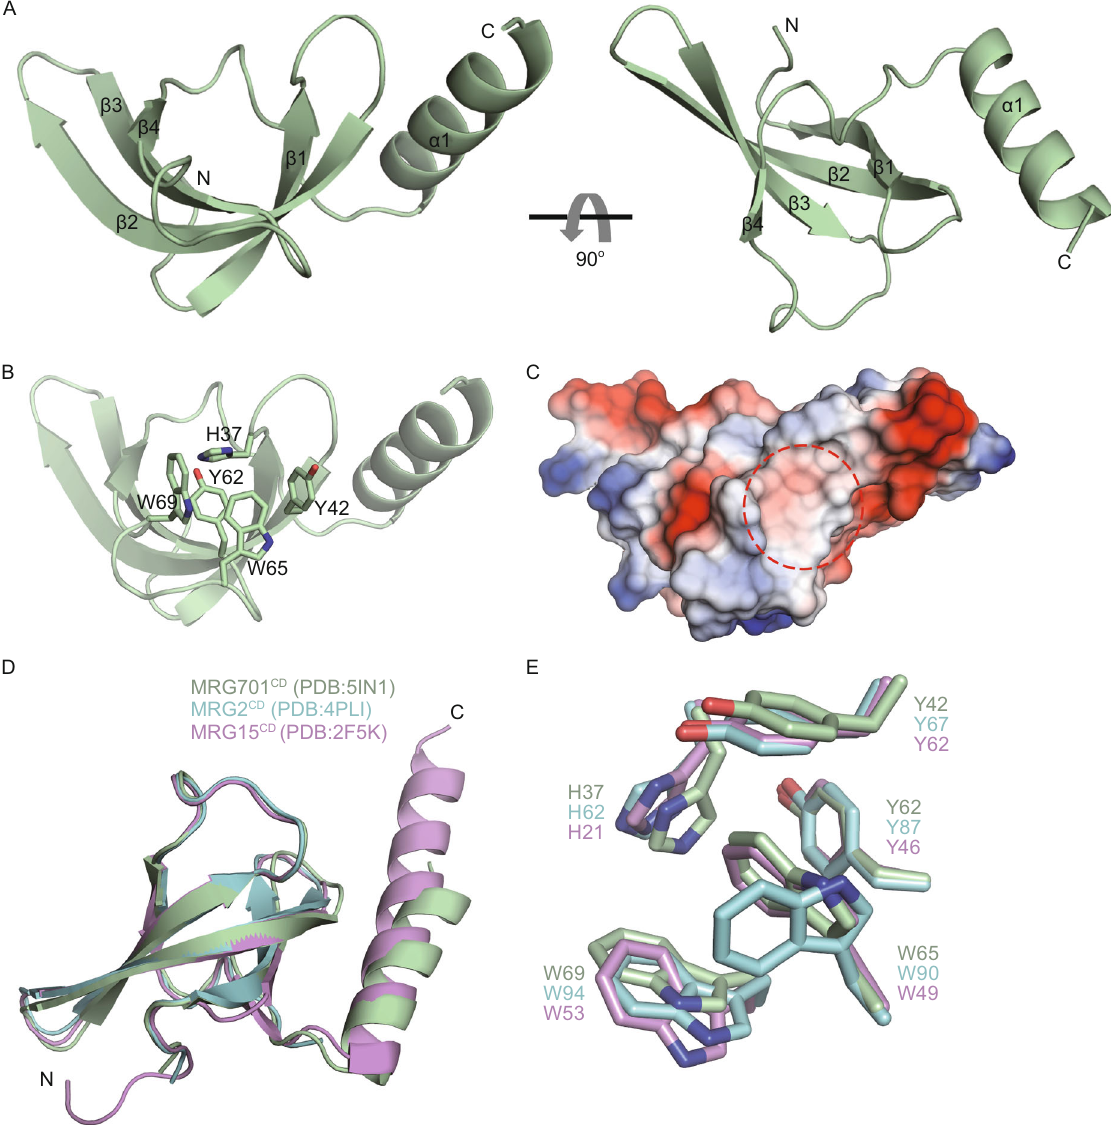
Figure 2. Overall structure of MRG701 CD . (A) MRG701 CD monomer consisting of four β -strands and one α -helix. View of 90° rotation around the horizontal axis is shown on right. (B) Residues consisting of aromatic cage are shown as sticks. (C) Electrostatic potential surface of MRG701 CD with histone binding cage indicated in red dashed circle (scale blue to red; positive to negative). (D) Structures of MRG701 CD , MRG2 CD , and MRG15 CD are superimposed and colored in light green, cyan, and violet, respectively. (E) Comparison of the aromatic cages of MRG701, MRG2, and human MRG15. Residues are shown as colored sticks as in (D).